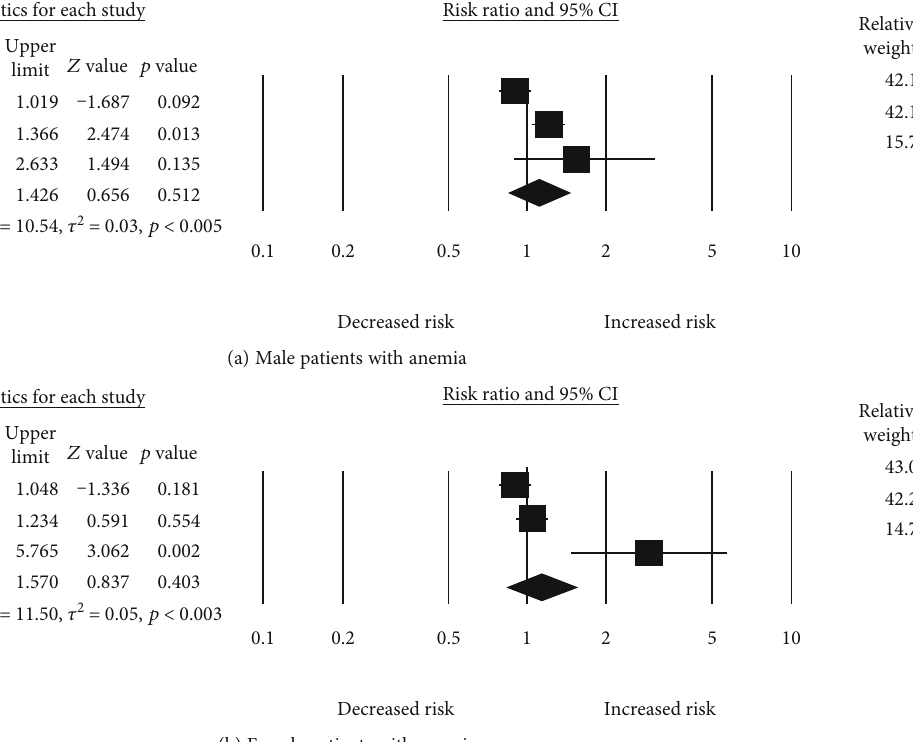
(b) Female patients with anemia Figure 3: Risk of